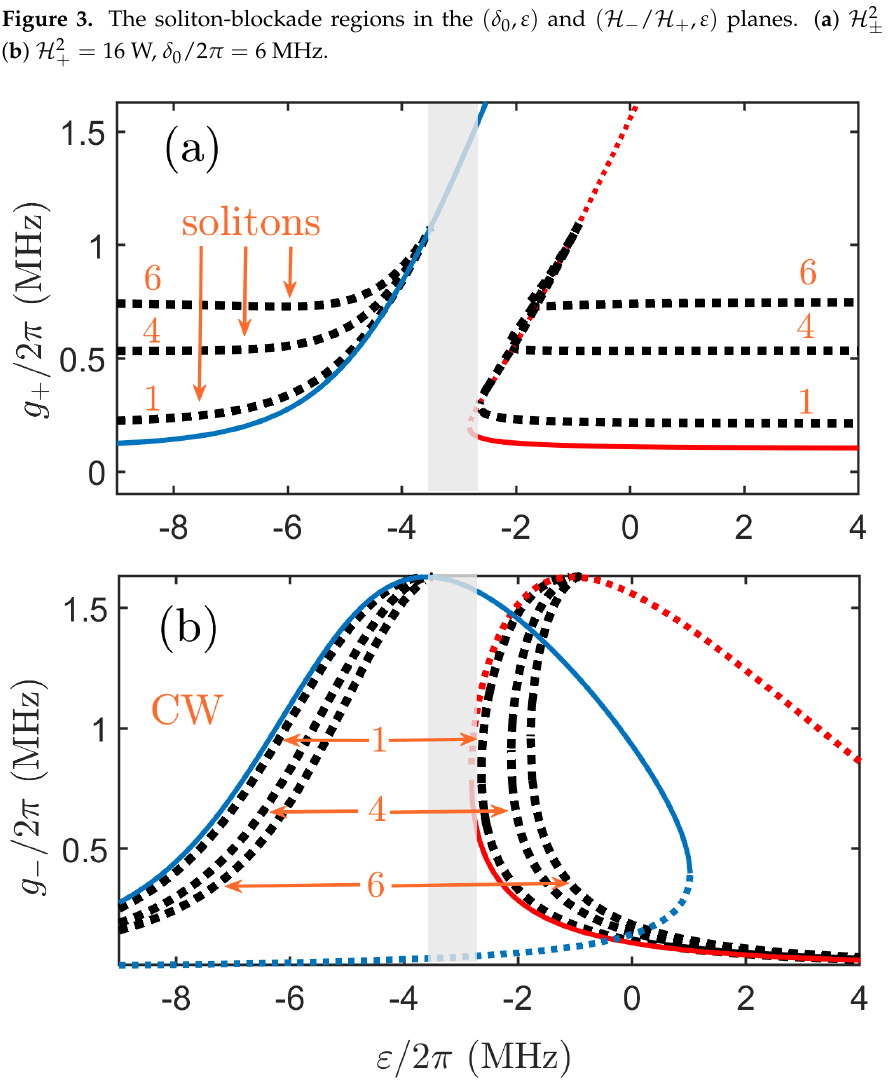
Figure 4. Soliton-cw states for δ 0 /2 π = 6 MHz. The other parameters are as in Figure 2c: ( a ) g + (soliton); and ( b ) g − (cw) vs. ε . The numbers 1, 4, and 6 indicate the soliton-crystal states with the respective number of the equally spaced solitons (Figure